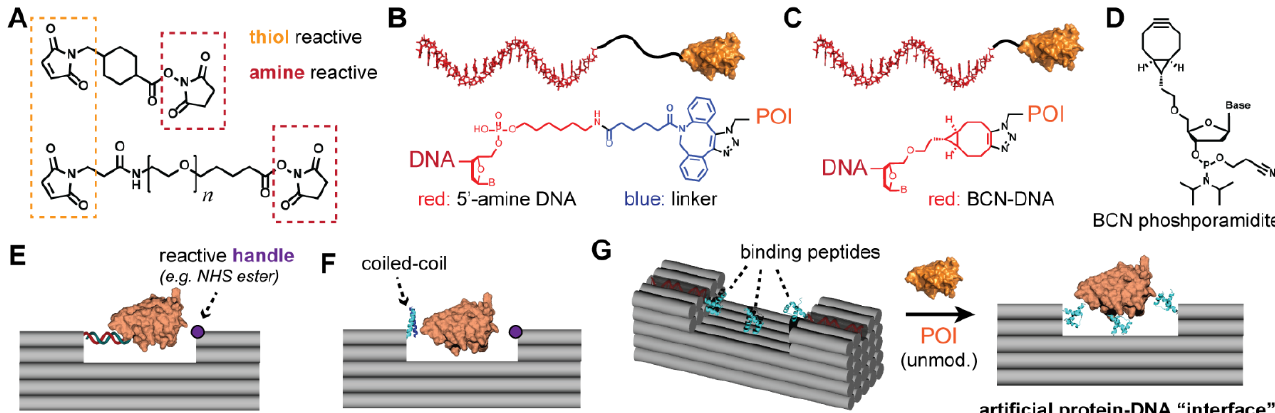
Figure 6. Chemical conjugation strategies. ( A ) Examples of two commercially available linkers for attaching thiols (e.g., a cysteine on a protein) to amines (e.g., a modified oligonucleotide). ( B ) Example of a protein-DNA conjugate from strain-promoted azide-alkyne cycloaddition (SPAAC) between an azide-containing protein and DNA modified with dibenzocyclooctyne (DBCO)-N-hydroxysuccinimide (NHS) ester [57]. Both the DNA amine modification (red) and the DBCO-NHS (blue) introduce flexible alkyl linkers between the oligonucleotide and the protein of interest (POI). ( C ) Using a bicyclononyne (BCN) directly attached to the 5 ′ end of DNA for SPAAC reduces the linker length by more than half compared with DBCO-NHS [58]. ( D ) Structure of a BCN phosphoramidite for introduction of the cyclooctyne at the 5 ′ end of DNA via solid-phase synthesis. ( E ) Attaching a POI to a DNA nanostructure with a first handle, and positioning a second reactive handle (purple) on the DNA structure in close proximity to the protein surface. ( F ) Using a coiled-coil, with one peptide attached to the DNA structure and the other genetically fused to the protein, avoids initial protein-DNA conjugation. ( G ) Positioning three binding peptides on a DNA nanostructure may allow for immobilization of an unmodified POI simply through multivalent binding interactions.